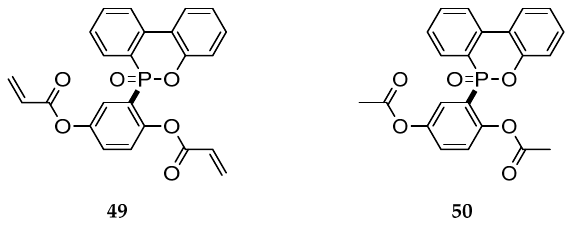
Figure 22. DOPO based phosphinate derivatives 49 and 50 .